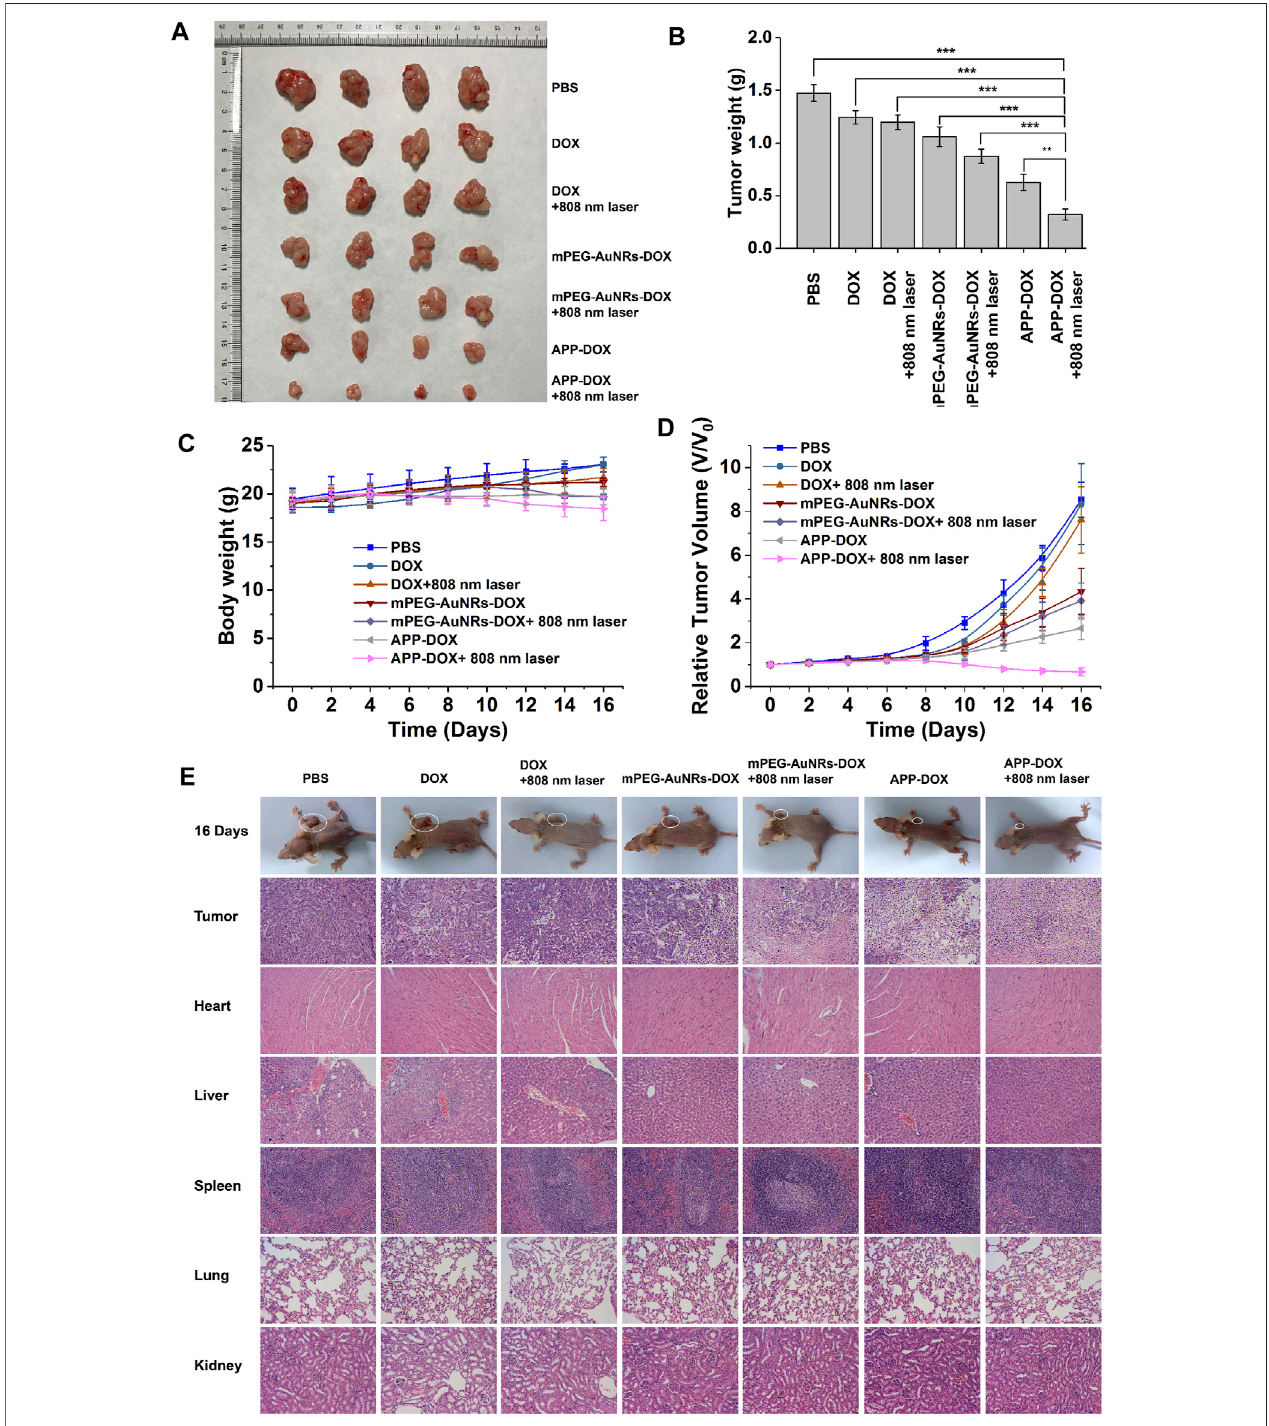
FIGURE 5 | The ef fi cacy of PBS, DOX, mPEG-AuNRs-DOX, and APP-DOX in treatment of subcutaneous hepatocellular carcinoma xenograft tumours in nude mice.Imagesofthetumoursinnudemice (A) .Bargraphoftumourweightineachgroupofnudemice (B) .Weightchangecurvesofthevariousgroupsofnudemice (C) . Curves of the relative tumour volume change (D) . Photographs of nude mice and H&E staining images of the pathological sections of tumours and main organs (heart, liver, spleen, lung, and kidney) (E) .